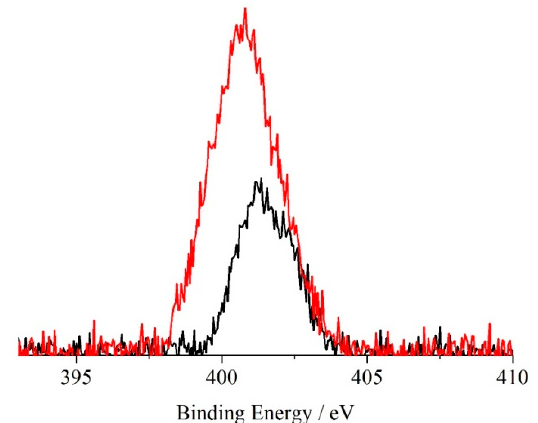
Figure 8. Al K α excited XPS of a representative PES electrospun mat with ZnTPP before (black line) and after sensing of the p-NA (red line) in the N 1s binding energy region. The signal intensities have been normalized to results of the atomic concentration analysis.